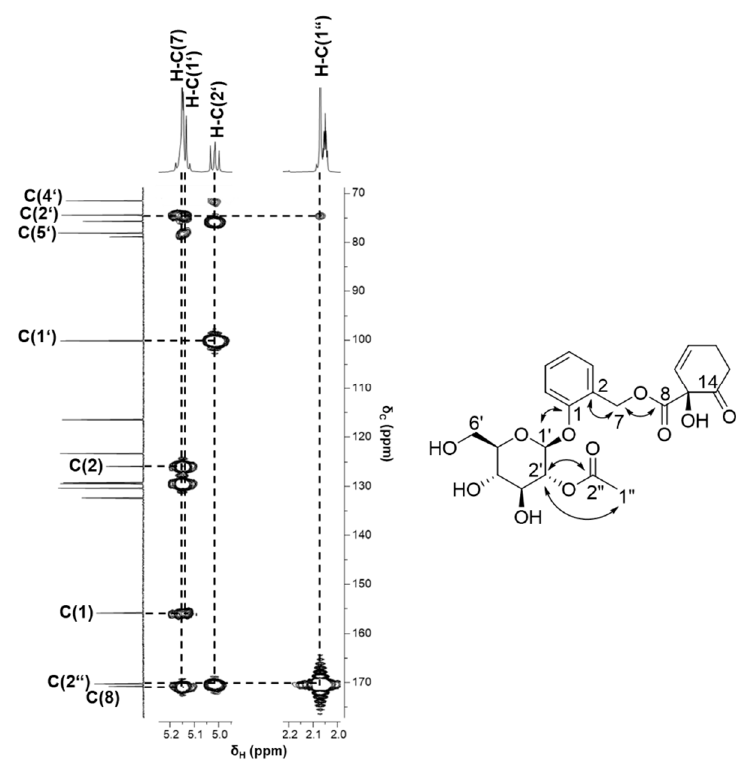
Figure 4. Heteronuclear multiple bond correlation (HMBC) of 1 , indicating the correlations between the sugar unit with the acetyl group and the phenolic ring, as well as the coupling between the methylene protons H-C(7) and the carbonyl carbon atom C(8).